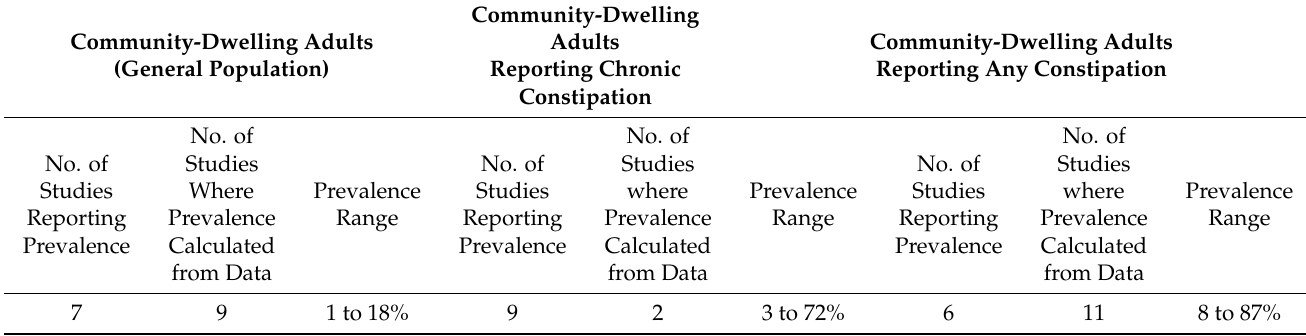
Table 2. Range of prevalence of laxative use in community-dwelling adult